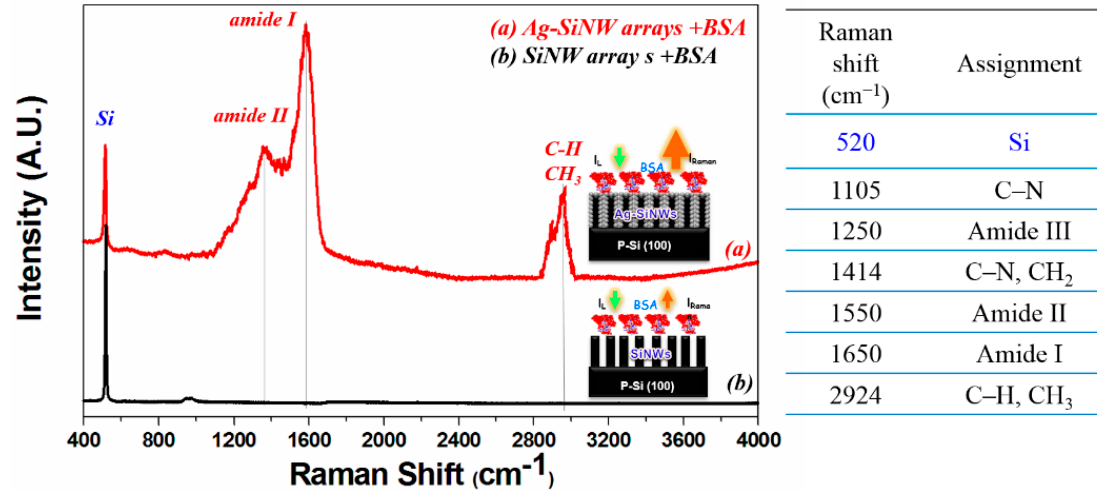
Figure 11. Comparison of SERS spectra of BSA immobilized onto ( a ) Ag–SiNW arrays (red line) and ( b ) SiNW arrays (black line).